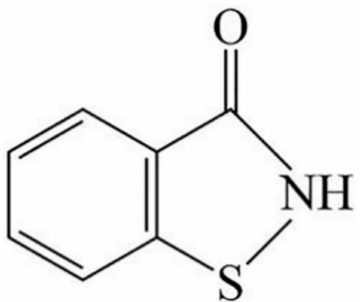
Figure 1. Structure of